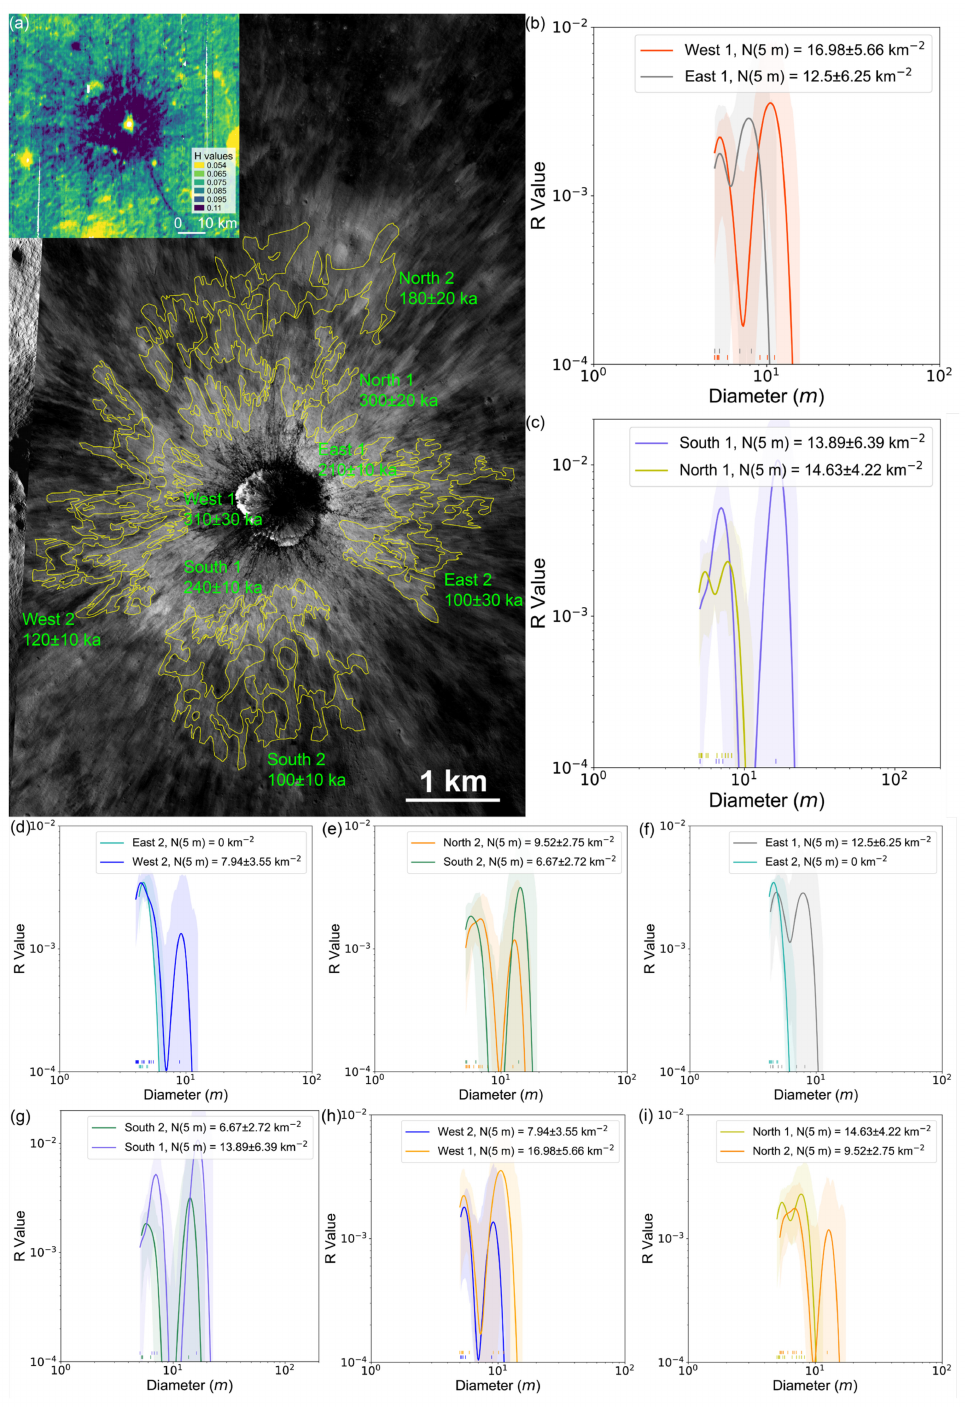
Figure 5. Crater size-frequency distributions on layers of ejecta flows around a cold spot crater ( D = 1051 m) that is centered at 120.12 ◦ E, 29.73 ◦ S. ( a ) The ejecta deposits do not exhibit obvious azimuth asymmetry, although dark ejecta are preferentially on at the western rim. Solar illumination is from the right, and north is up. The inset figure is the H-map of the cold rays, whose distributions do not exhibit obvious azimuth asymmetries either. The yellow areas show the locations of the eight counting areas that are aligned with their model ages. IDs of data used in this figure are compiled in the Supplementary Materials. ( b – e ) compare the crater size-frequency distributions (SFDs) between the East1 and West1, South1 and North1, East2 and West2, South2 and North2, respectively. ( f – i ) compare the crater SFDs between the East1 and East2, South1 and South2, West1 and West2, North1 and North2,